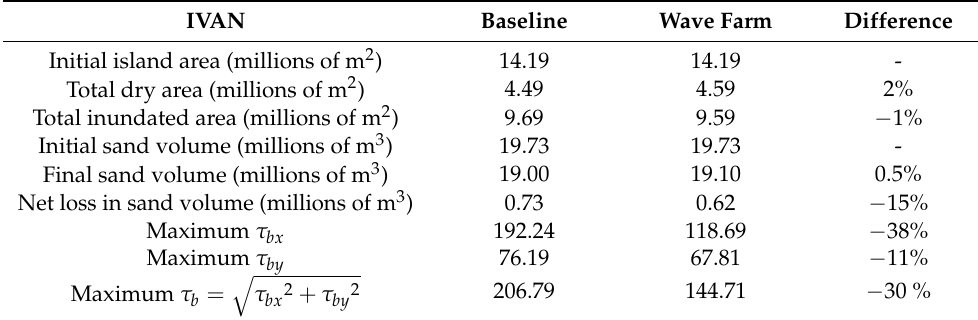
Table 1. Inundated and dry areas, initial and final sand volume, net loss in sand volume, and maximum bed shear stress values in x- and y-directions [N/m 2 ] averaged over time in the mid- domain nearshore area of Dauphin Island, AL under Hurricane Ivan conditions for baseline and wave farm